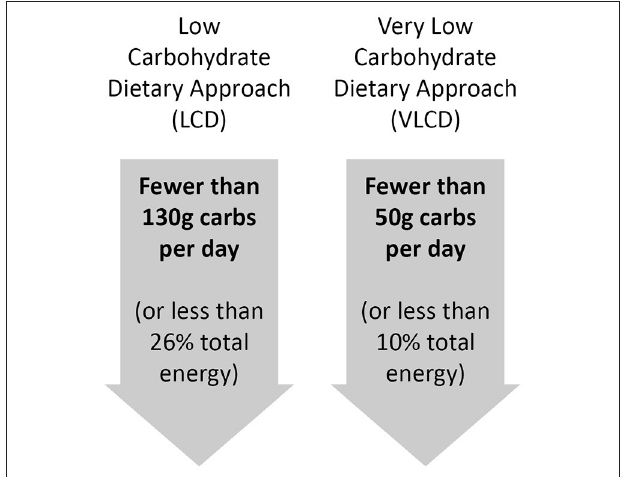
FIGURE 1 | Suggested definitions for low and very low carbohydrate dietary